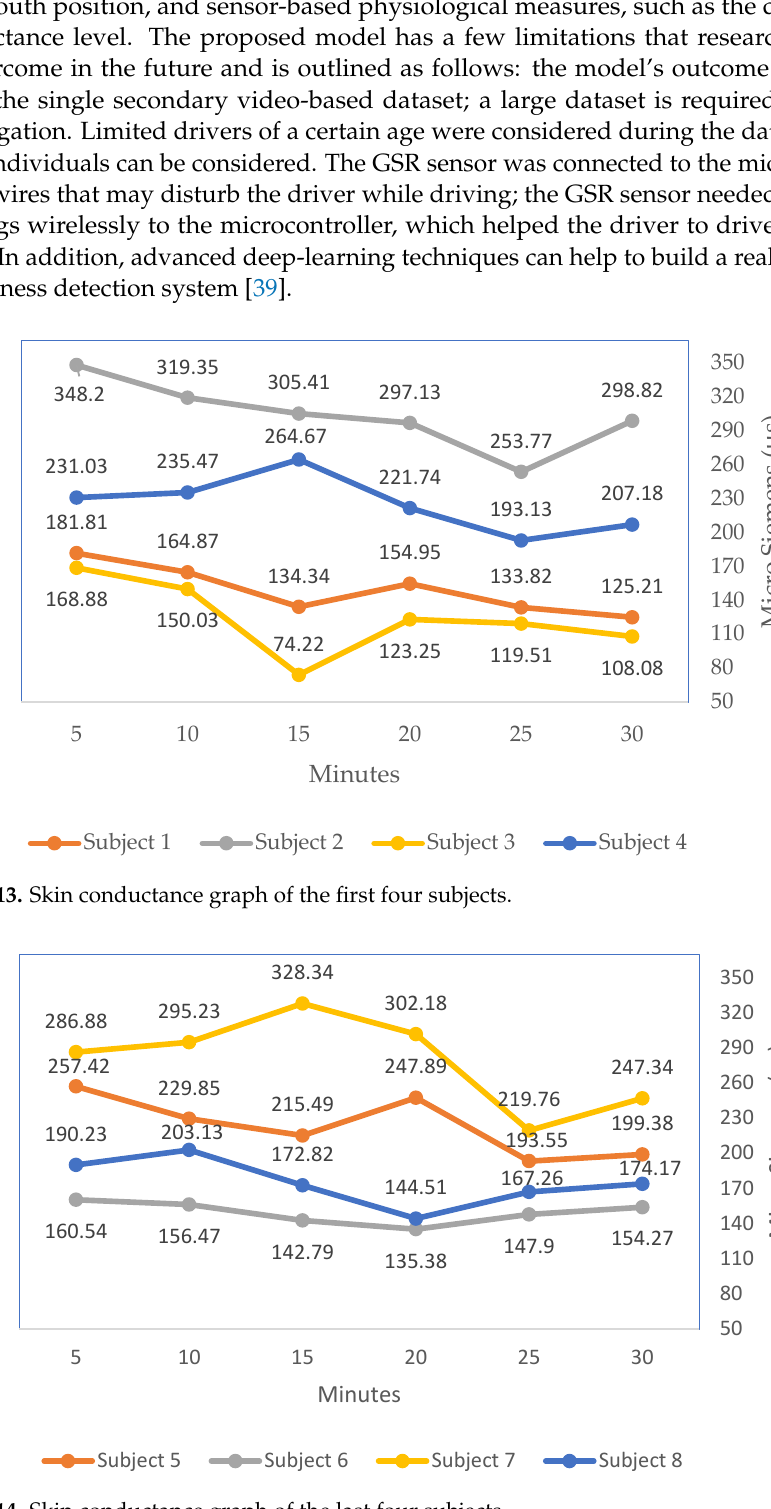
Figure 14. Skin conductance graph of the last four subjects .